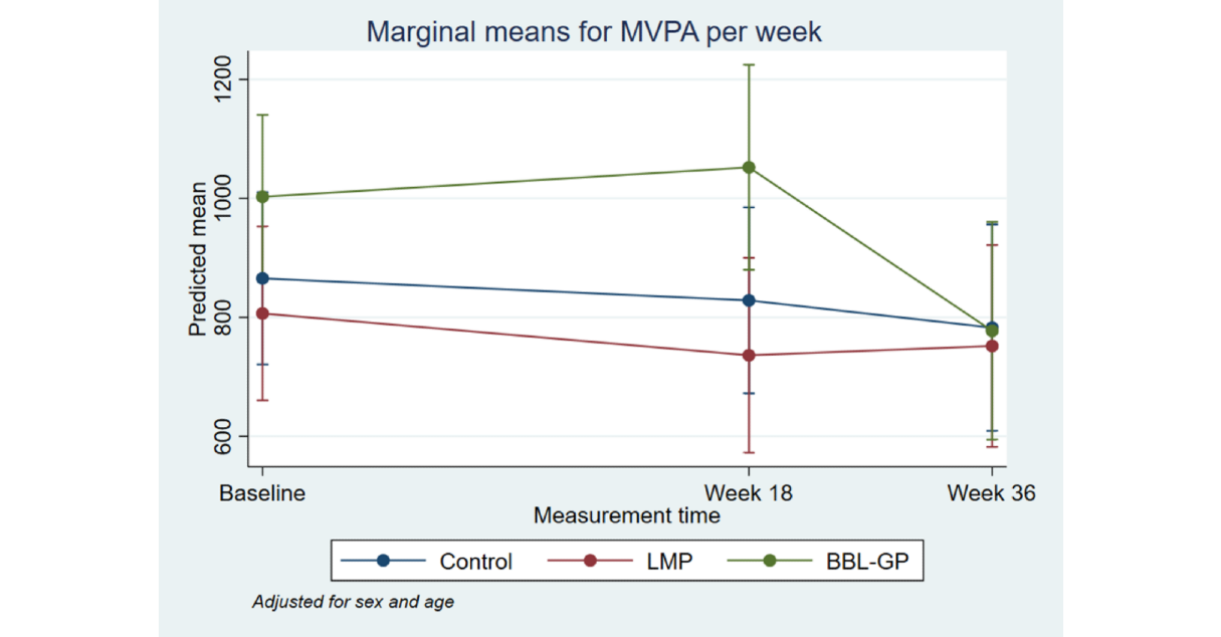
Figure 4. Mean moderate-to-vigorous physical activity with 95% CI, by time point and intervention group. BBL-GP: Body Brain Life in General Practice; LMP: Lifestyle Modification Program; MVPA: moderate-to-vigorous physical activity.